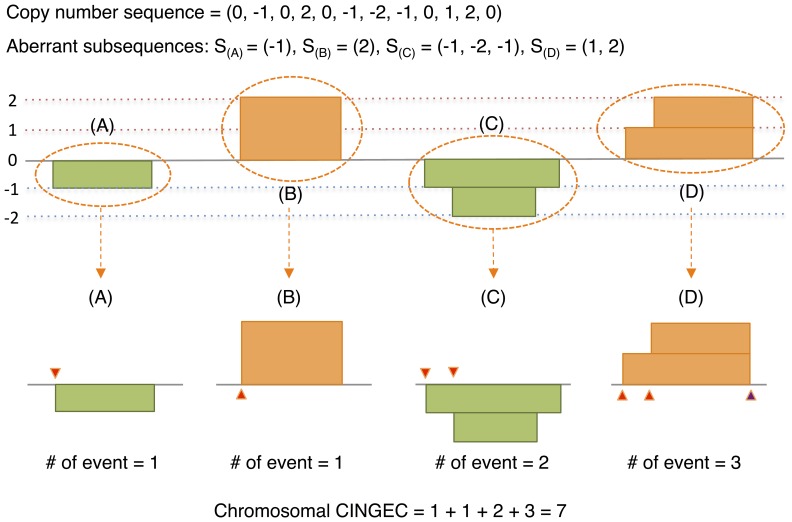
Schematic illustration of CINGEC algorithm for an artificial chromosome with a CNL sequence given by S = (0, -1, 0, 2, 0, -1, -2, -1, 0, 1, 2, 0).Aberrant subsequences for S are S(A) = (-1), S(B) = (2), S(C) = (-1, -2, -1), S(D) = (1, 2) and the number of events (marked by triangles in lower panels) for each subsequence following the algorithm is 1 for S(A), 1 for S(B), 2 for S(C), 3 for S(D) and the CINGEC for this chromosome is 7. Note that the event count for S(B) is 1 as in S(A) because CNL simply transits 0 → 2 in S(B). Also note that the event count for S(D) is 3 due to the last transition 2 → 0 (a transition into a level earlier than the immediate previous level 1) at the end of segment. In the algorithm, we assumed that two rugged end boundaries of levels 1 and 2 (as in S(C)) were truncated to an identical genomic locus by an additional event.